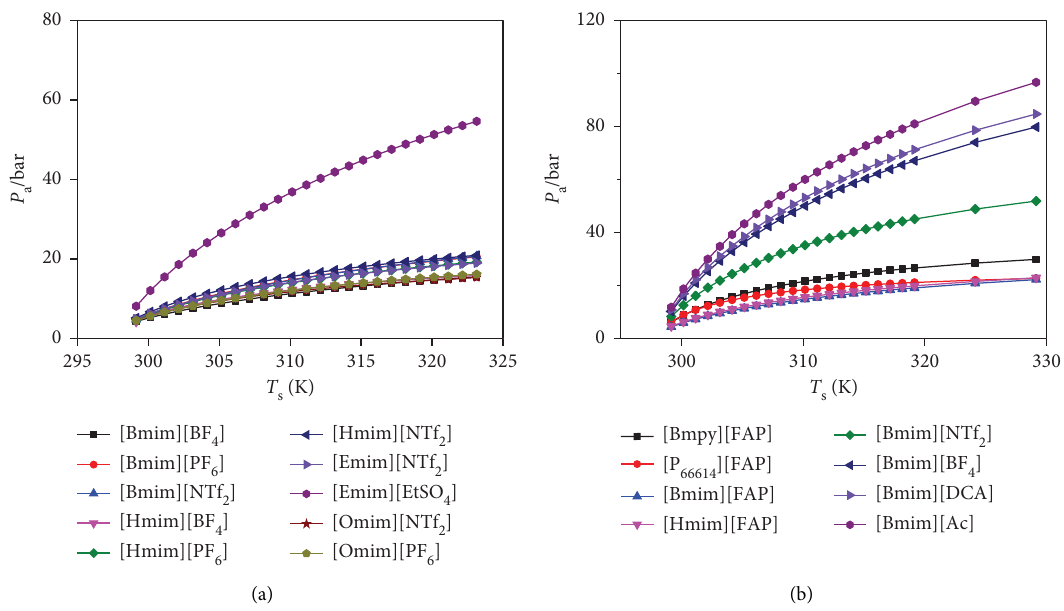
Figure 4: Te absorption pressures of (a) 10 physical absorbents for high-sulfur natural gas and (b) 8 physical absorbents for adipic acid